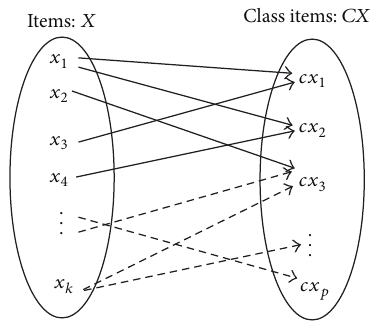
Figure 1: Mapping relationship of items and class items.